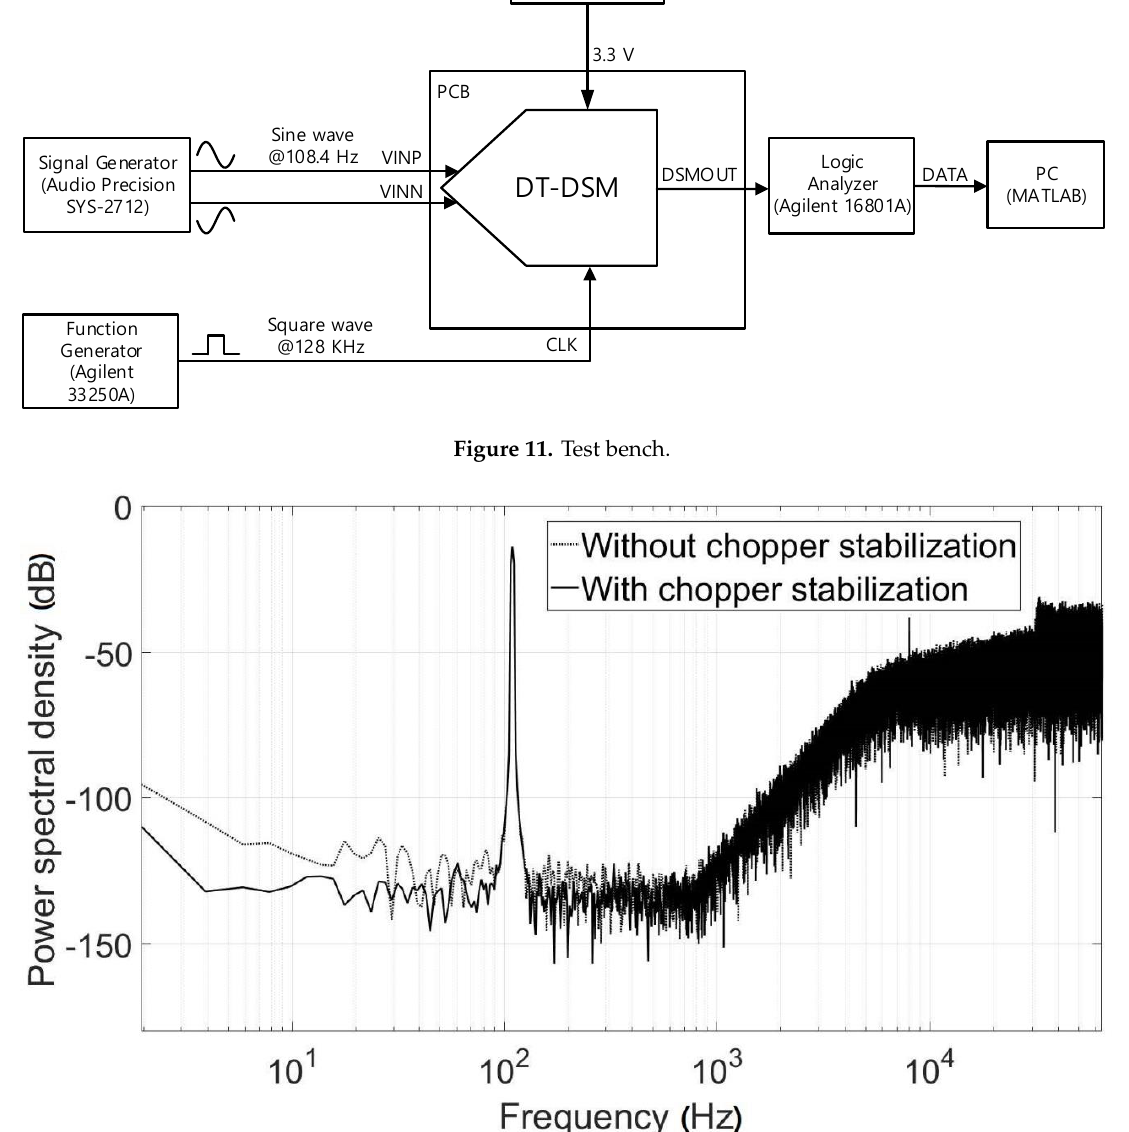
Figure 12. Measured output spectrum of the DSM chip.